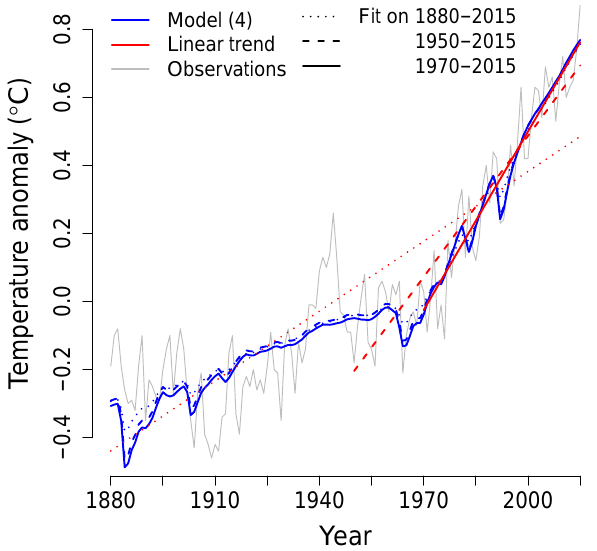
Figure 2. Comparison of the fitted values for model (4) and the lin- ear time trend model fitted to the global mean temperature record over different time frames. (The fitted model Eq. 4 trends are ex- tended back to 1880 regardless of the time frame used to fit the model.) The linear model appears in agreement with model (4) roughly after 1970, but not before. By contrast, model (4) produces fairly stable estimates of the mean response during the 20th century, although we note that the apparent fit to the data may be slightly poorer in the earliest part of the